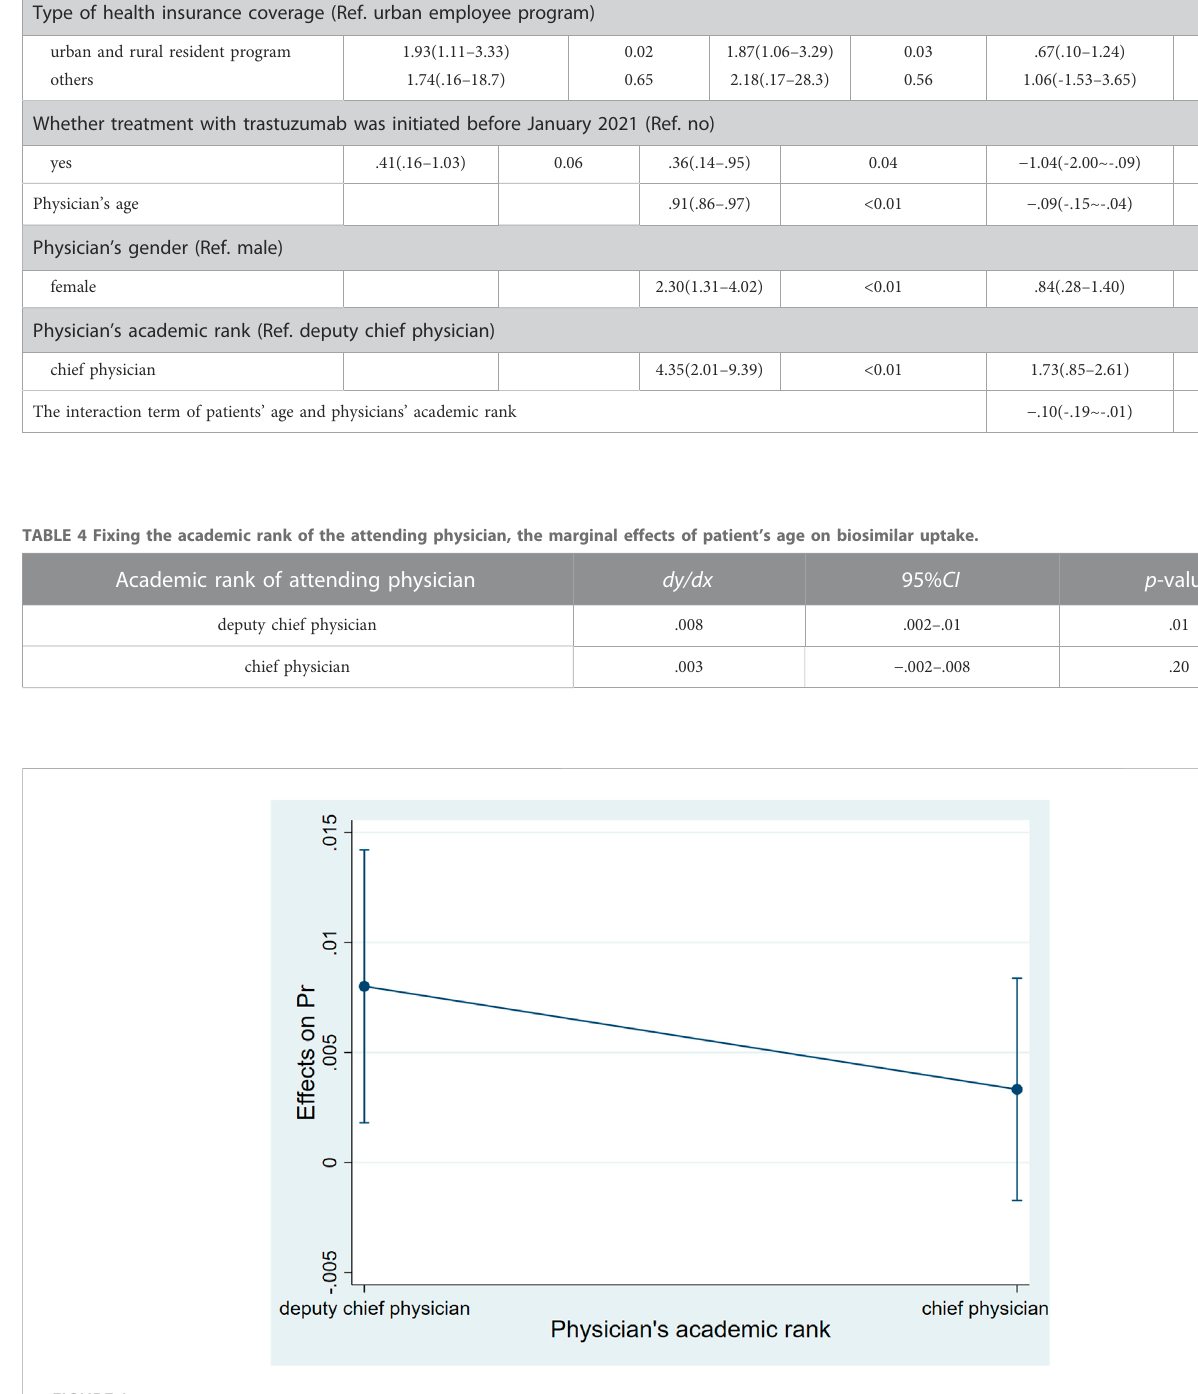
FIGURE 1 Average marginal effects of patient ’ s age with 95% CI when their attending physicians were with different academic ranks.